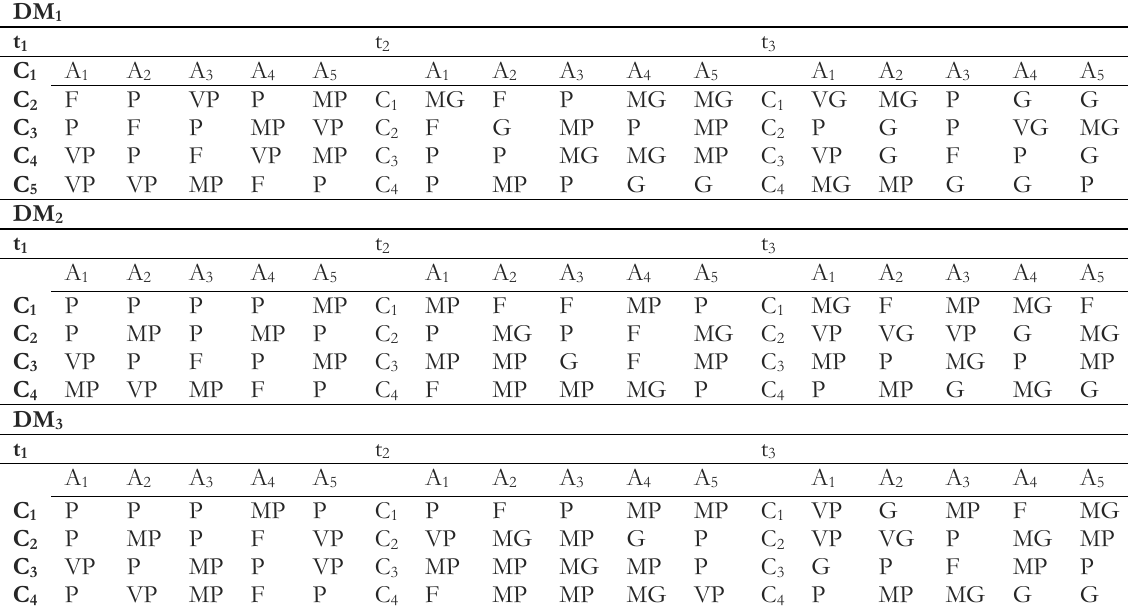
Table 2. Linguistic values of the evaluated attributes by three decision-makers in three periods of